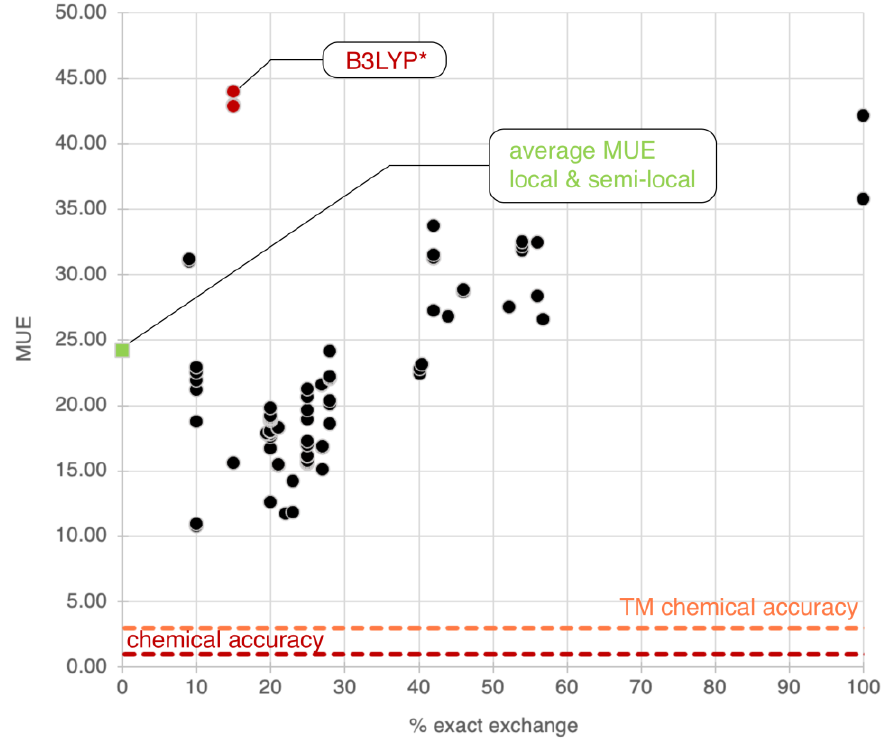
Figure 2. Distribution of the mean unsigned error (MUE) for the Por21 database for global hybrid functionals as a function of the percentage of exact exchange in each functional. The average MUE for the 107 local and semilocal functionals is also reported as a green square at 0%. The B3LYP* family is singled out as unusual outliners in red. Chemical accuracy and transition metal (TM) chemical accuracy are also reported. All values in this plot are in kcal/mol.